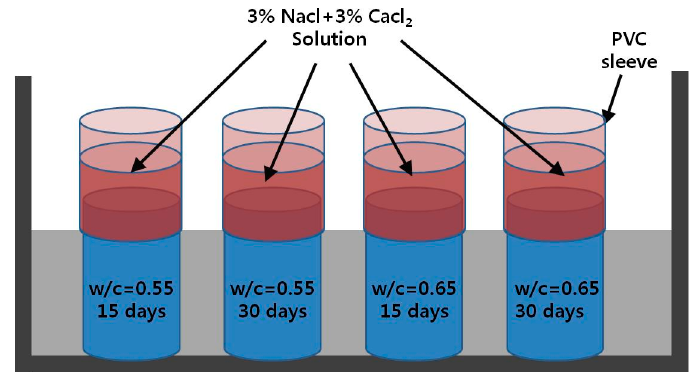
Figure 2. Experimental plan for penetration of deicing salt.